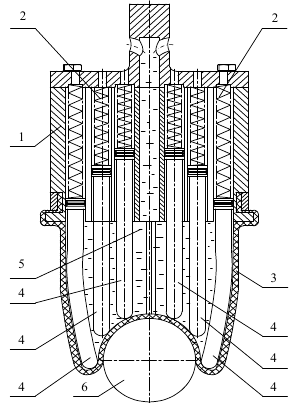
Figure 5. The expected improved design of CTSA hand, including components: 1, base; 2, spring; 3, balloon membrane; 4, pins; 5, gas or fluid; 6, object.